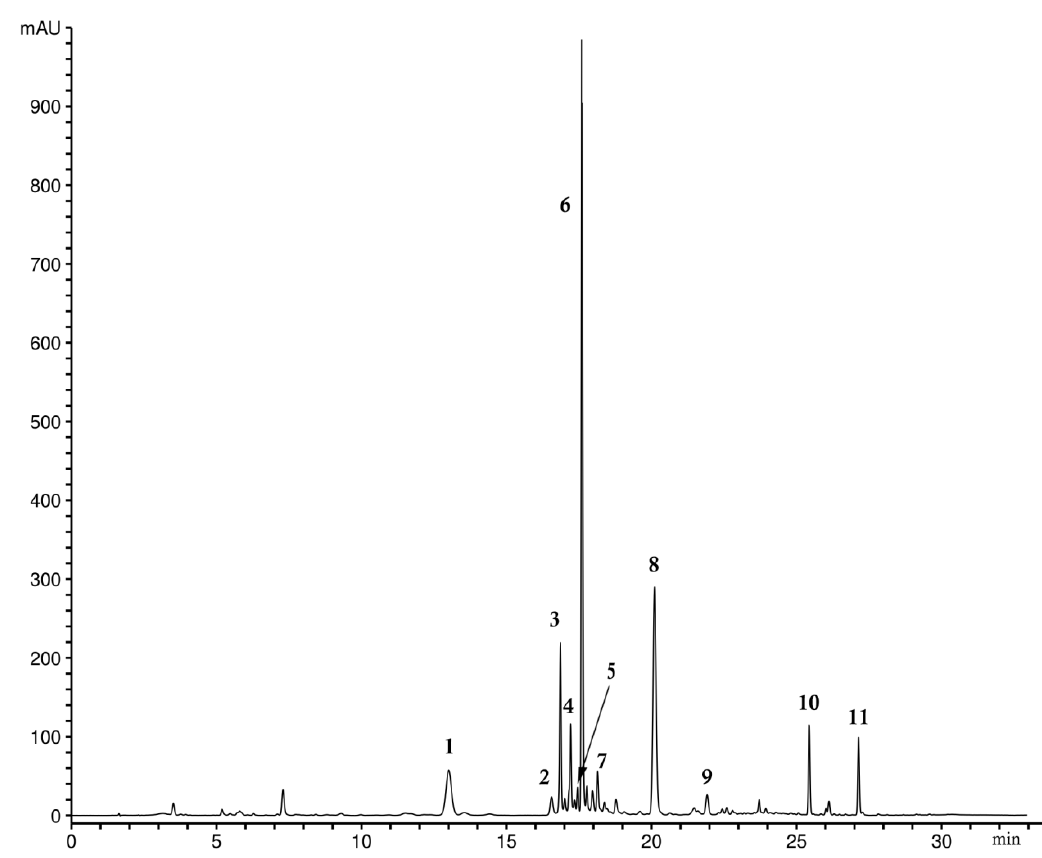
Figure 2. HPLC profile ( λ = 260 nm) of methanol extract of G. lutescens . Peaks: 1—swertiamarin, 2—gentiopicrin, 3—mangiferin, 4—campestroside, 5—isoorientin, 6—demethylbellidifolin-8- O -glucoside, 7—swertisin, 8—bellidifolin-8- O -glucoside, 9—veratriloside, 10—demethylbellidifolin, 11—bellidifolin.